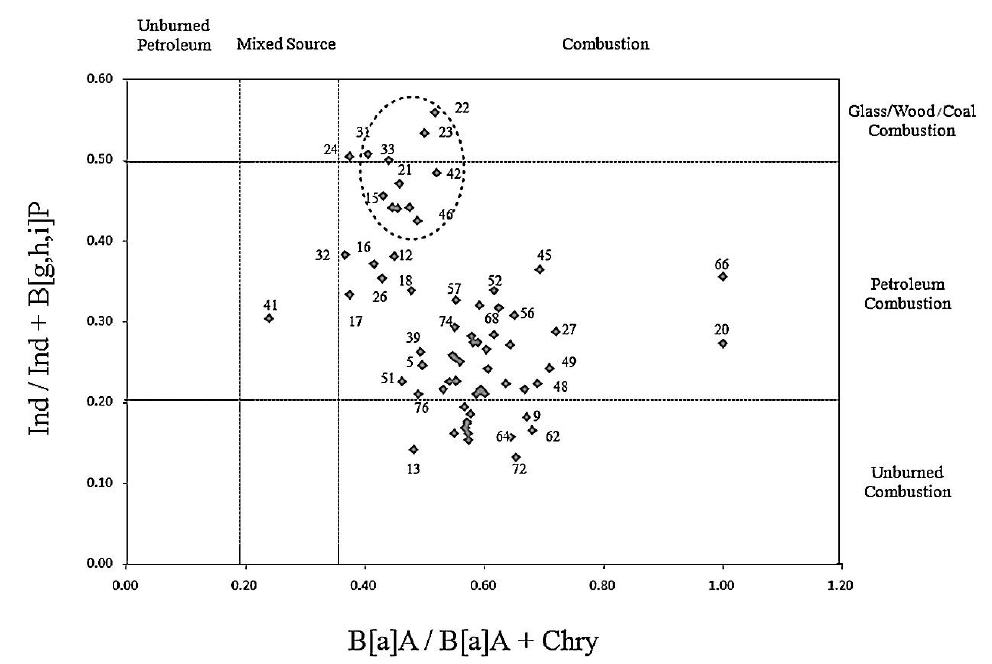
Fig. 3. Cross-plot between ratios Ind/Ind+B[g,h,i]P and B[a]A / B[a]A+Chry (numbers indicate sampling stations; the dashed circle repre- Figure 3. Cross-plot between ratios Ind/Ind+B[g,h,i]P and B[a]A / B[a]A+Chry 2 sents the stations in which PAHs were originating from road paving asphalt). (Numbers indicate sampling stations; The dashed circle represents the stations which 3 PAHs were originating from road paving asphalt). 4